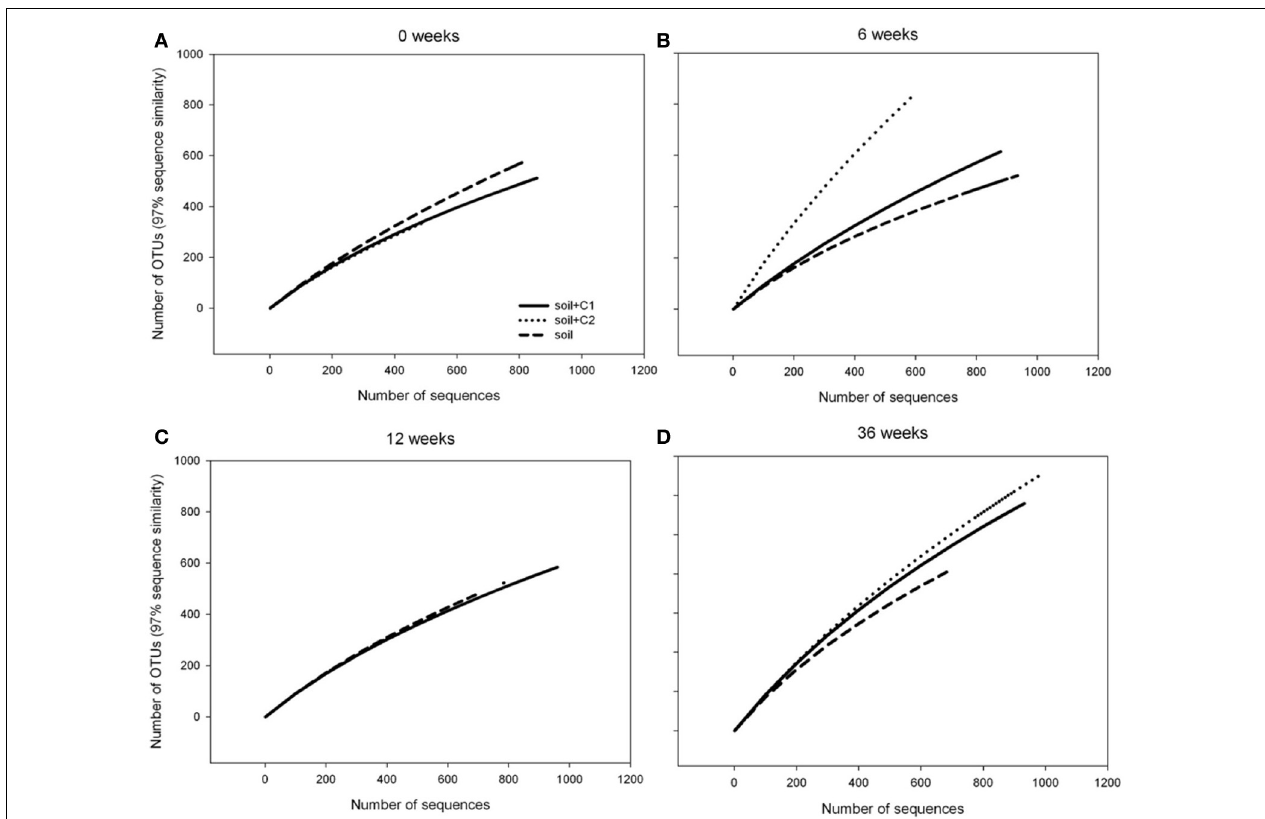
FIGURE 3 | Rarefaction curves of alkB gene fragments for each treatment at different sampling time points.